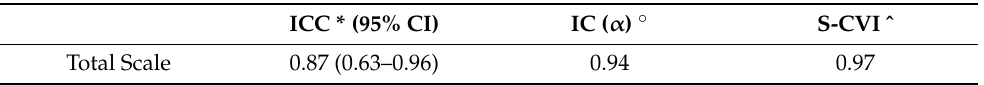
Table 2. Internal consistency, reliability, and validity of the Italian version of adult Vaccine Hesitancy Scale (aVHS) for the working-age population. ICC * (95% CI) IC ( α ) ◦ S-CVI ˆ Total Scale 0.87